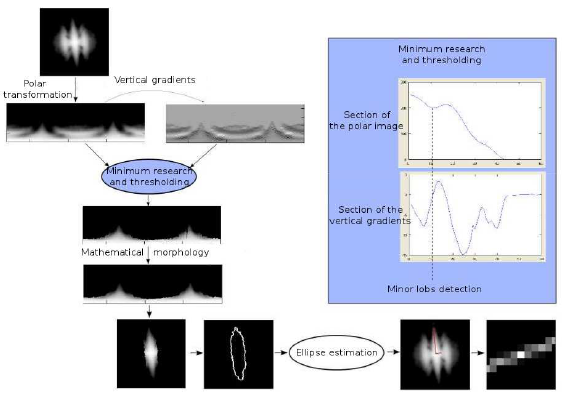
Figure 4. Minor lobes